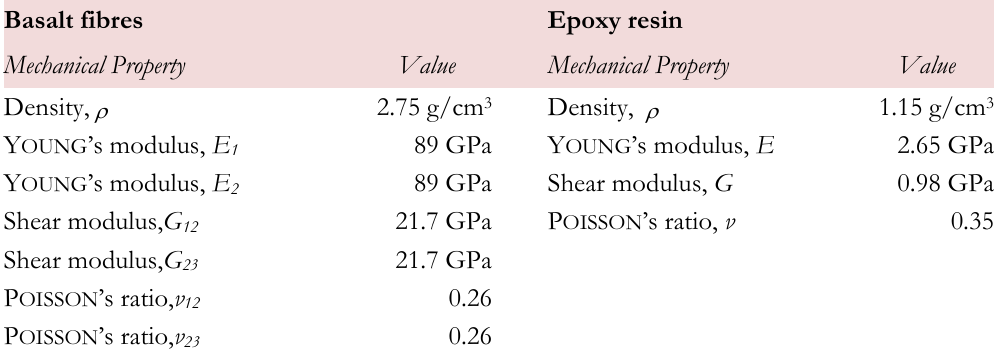
Table 1: Mechanical properties of basalt fibres [12] and epoxy resin [6].